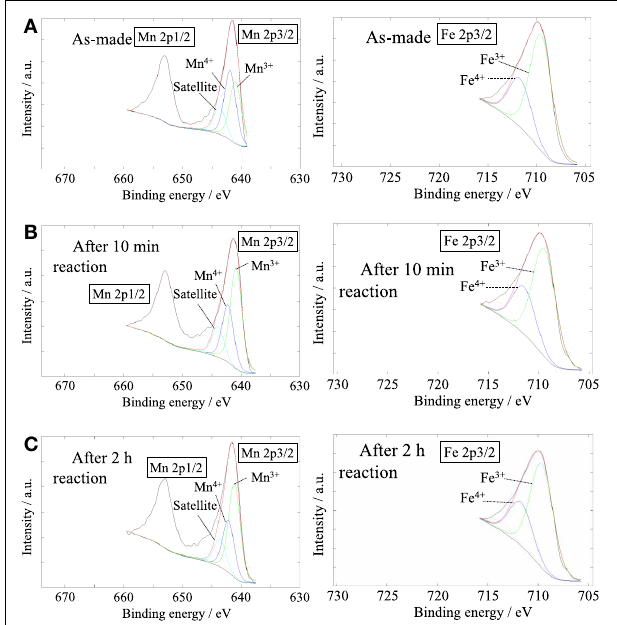
FIGURE 5 | XPS spectra of Mn2p (left) and Fe 2p3/2 (right) for Ba 0 . 4 Sr 0 . 6 Fe 0 . 6 Mn 0 . 4 O 3 − δ ; (A) as-made, (B) after 10min of reaction, (C) after 2h of reaction.